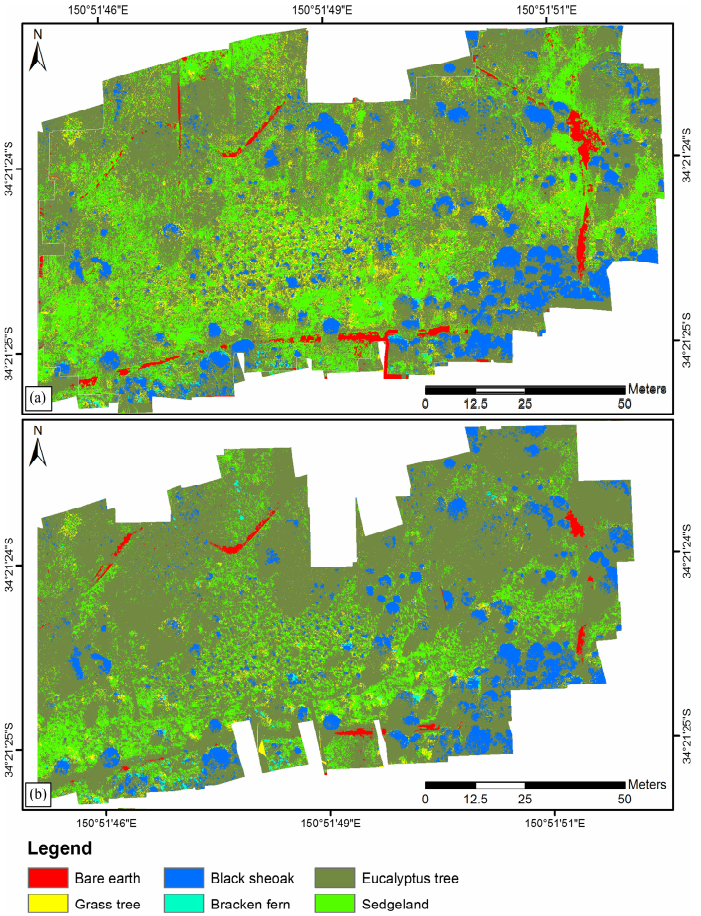
Figure 4. Classification map of the swamp site’s vegetation classes and species produced using a support vector machine classifier with ( a ) data-driven (PSO-MEAC) optimal band identification and ( b ) indices-based band selection.